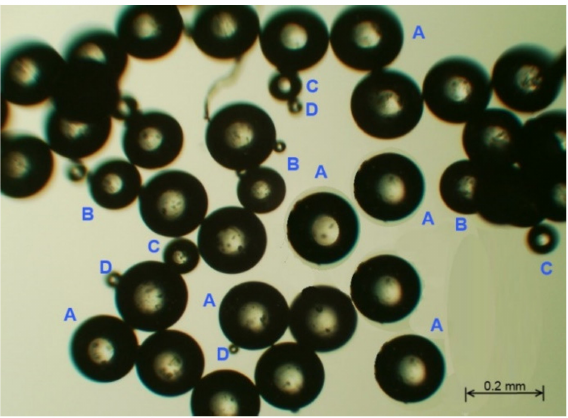
Figure 1. Optical microscopy image of the fabricated poly(HDDA)/graphene microspheres.